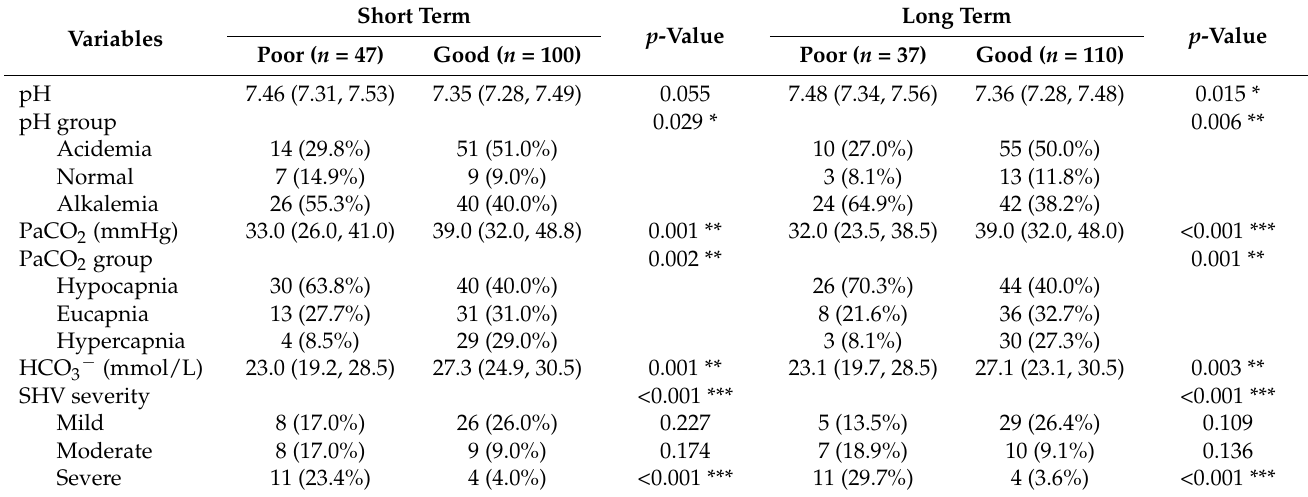
Table 3. The relationship between arterial blood gas test results and outcomes.